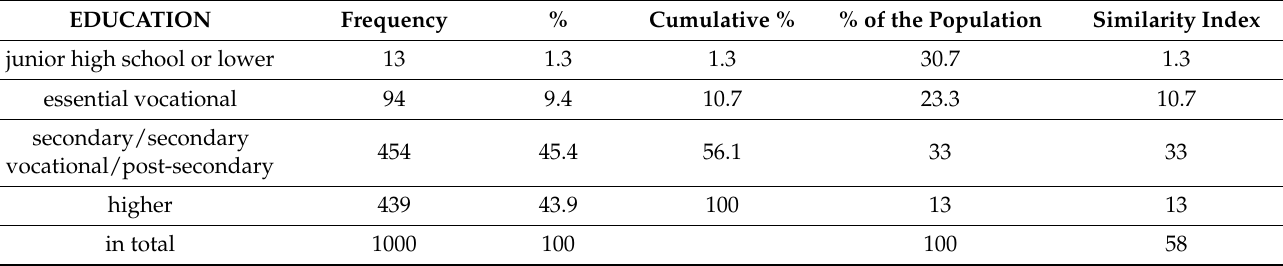
Table 3. Education of the respondents.